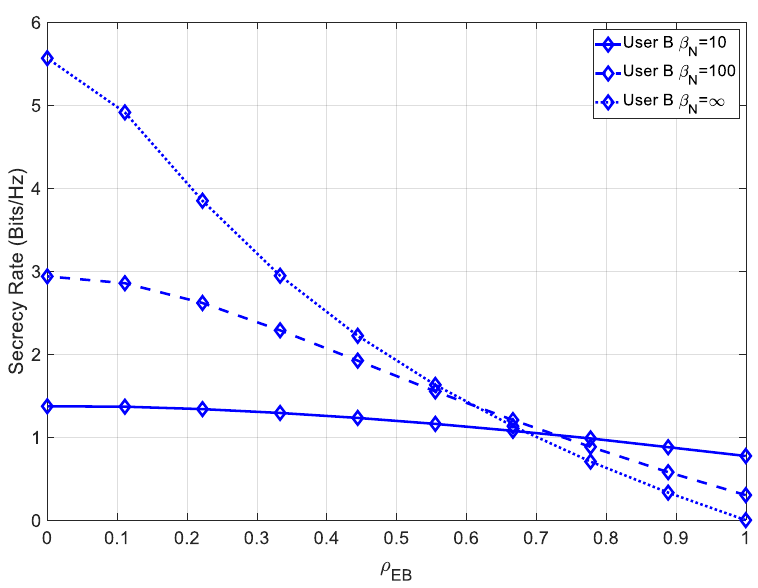
Figure 6. Secrecy rate of the 8 × 8 receiver B with different channel estimation errors.